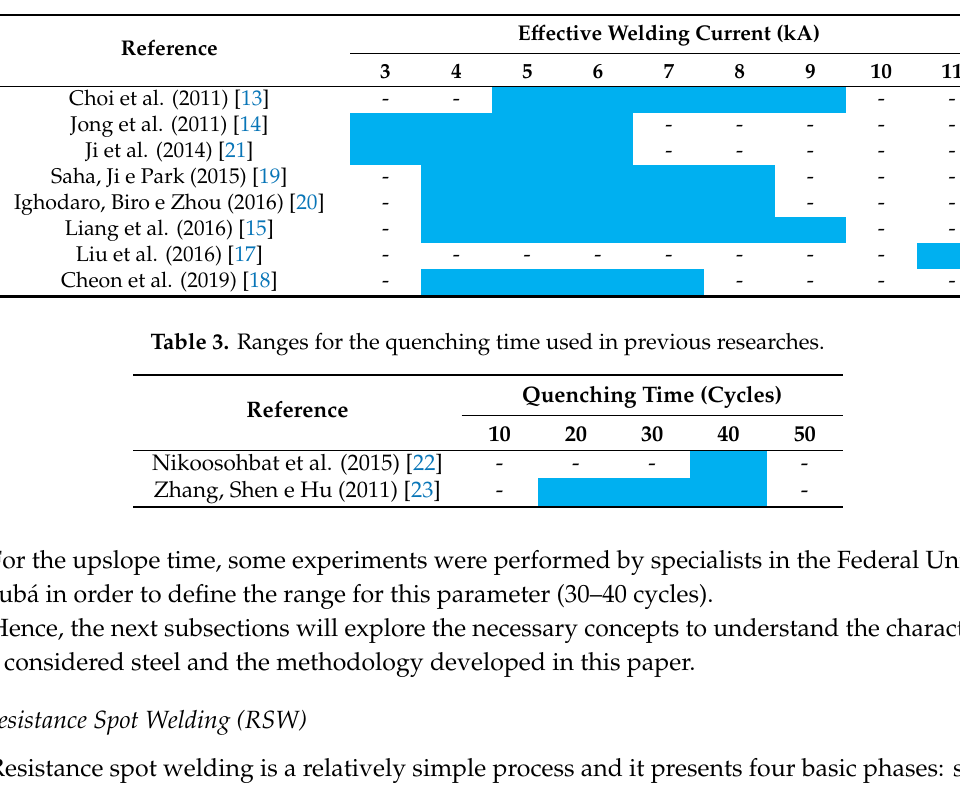
Table 2. Ranges for the e ff ective welding current used in previous researches.